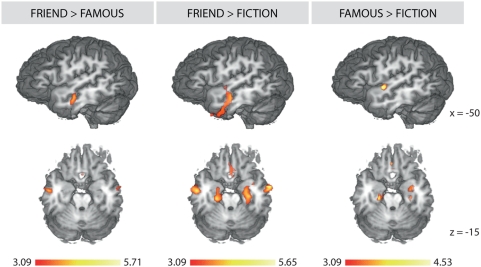
Other Relevance Patterns.Each column shows activations resulting from the indicated contrast. The left column shows results from the Friend>Famous contrast (inclusive mask: Friend>Control), the middle column shows results from the Friend>Fiction contrast (inclusive mask: Friend>Control) and the right column shows results from the Famous>Fiction contrast (inclusive mask: Famous>Control). All reported activations were corrected for multiple comparisons (p<.05) by employing cluster-size thresholding using Monte-Carlo simulations (initial height threshold: z = 3.09). The top row shows the activation profile in the left lateral temporal gyri whereas the bottom row depicts the activation profile in the bilateral hippocampal formation across contrasts.